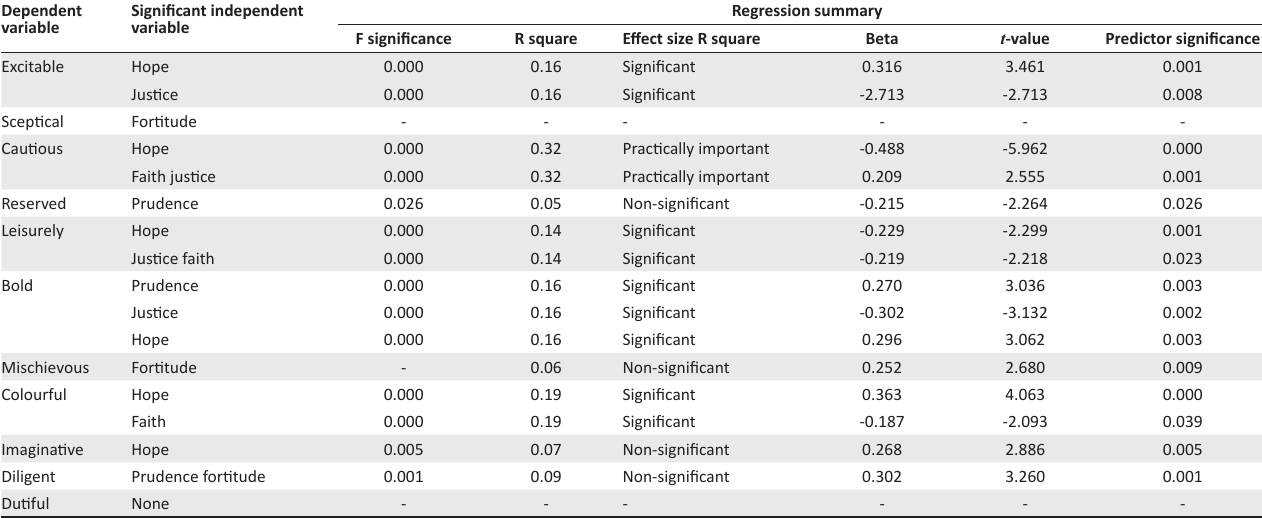
TABLE 4: Summary of regression analyses predicting each of the various derailing dimensions by means of the Giotto integrity